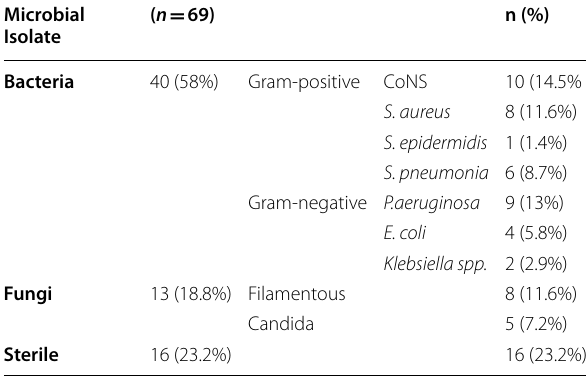
Numbers with different letters are significant MC Monte carlo, p : p -value for comparing between the studied groups * Statistically significant at p 0.05 ≤